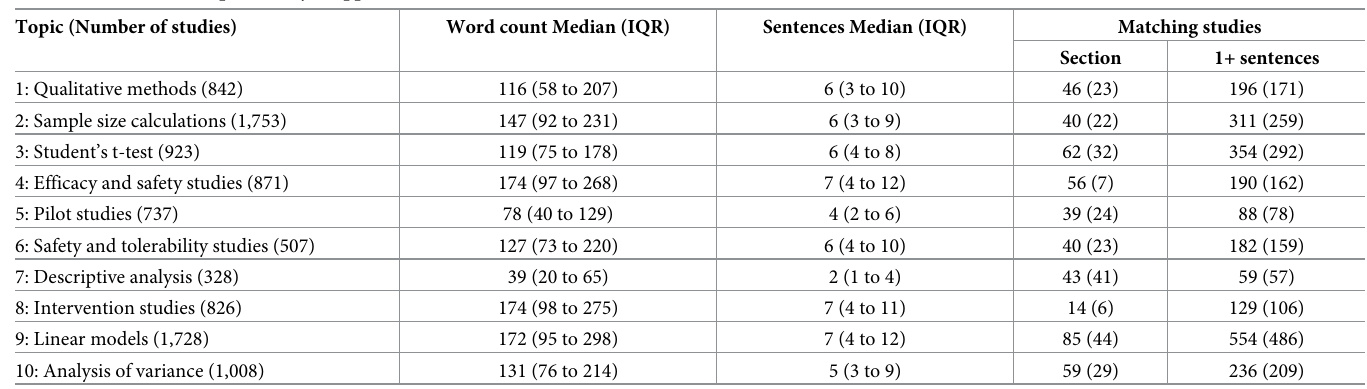
Table 3. Results of boilerplate analysis applied to the ANZCTR